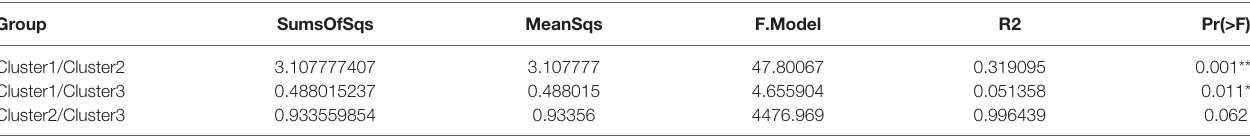
TABLE 2 | Results of permanova analysis of variance among clusters (permutation = 10,000). Group